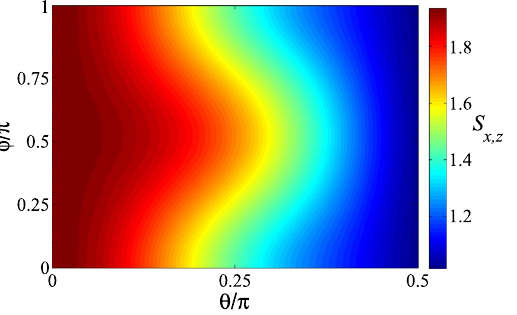
Figure 7. The variation of entropic sum, S x , z , with respect to the polar angular ( θ ) and phase ( φ ) of the initial state constructed with Ω = t 10 and Θ = . t 1 5 .